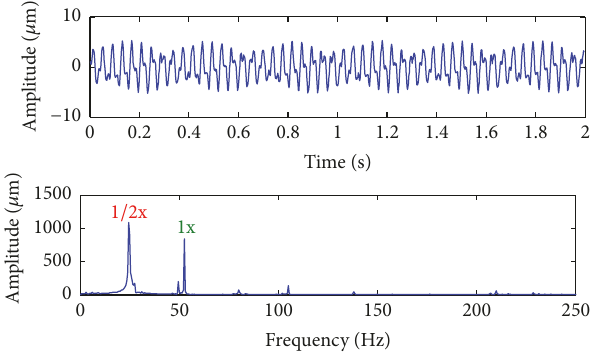
Figure 6: Time Domain waveform and spectrum of oil whirl signal.